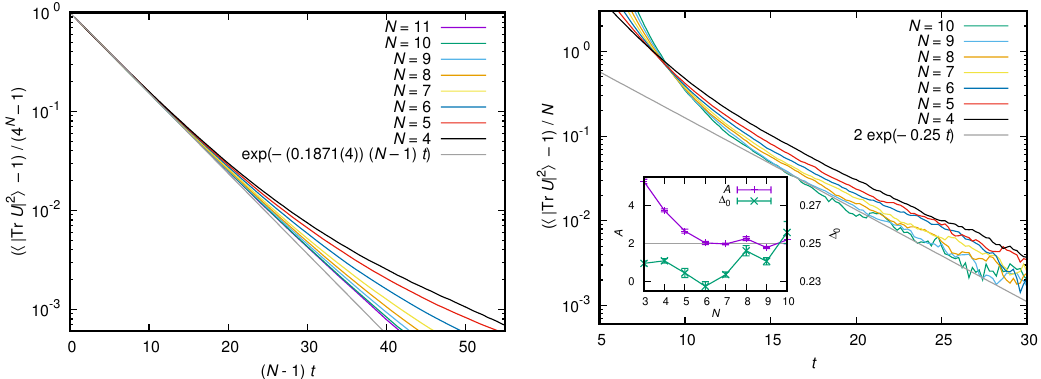
Figure 20 . Plot of hj Tr U k j 2 i (cid:0) k for k = 1 ; 2 ; 3 ; 4 ; 5 for the local RCQ chain with dt = 0 : 2 for N = 9 qubits. The decay time scale appears to grow with k for k (cid:21) 2.